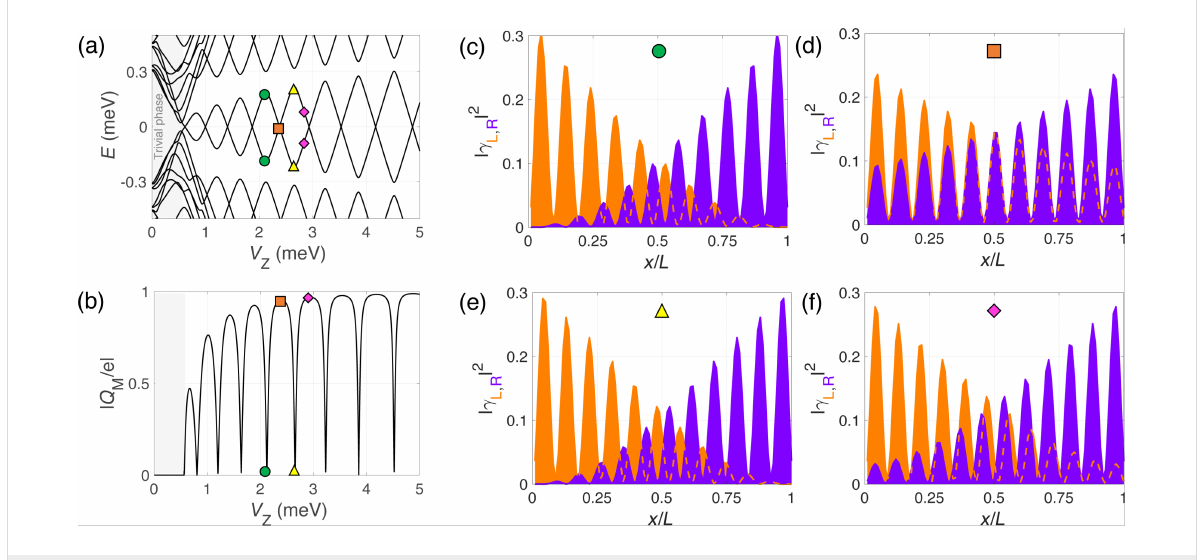
Figure 3: Majorana wave functions in the non-interacting case: Energy levels (a) and the absolute value of the Majorana charge Q M (b) as functions of the Zeeman energy. Panels (c–f) show the wave-function probability profiles of the two lowest-energy states in the Majorana basis at selected values of the Zeeman field within the topological region. When the splitting is maximum (green circles and yellow triangles) the left and right Majorana wave-function oscillations are out of phase, whereas when the splitting is zero (orange square) they are in